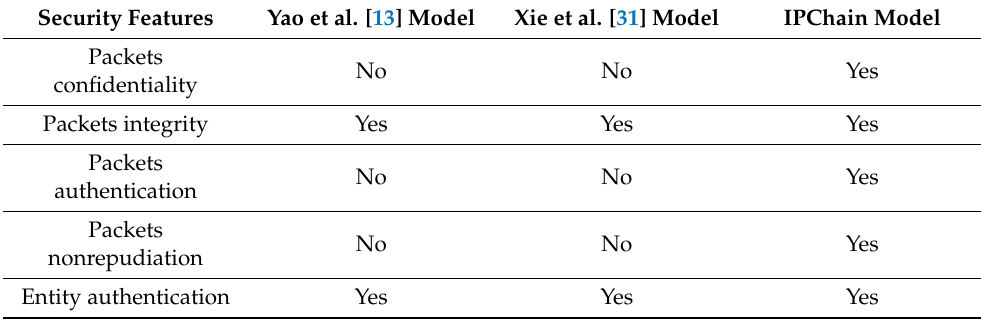
Table 4. Security performance metrics between Yao et al., Xie et al., and the IPChain models. Security